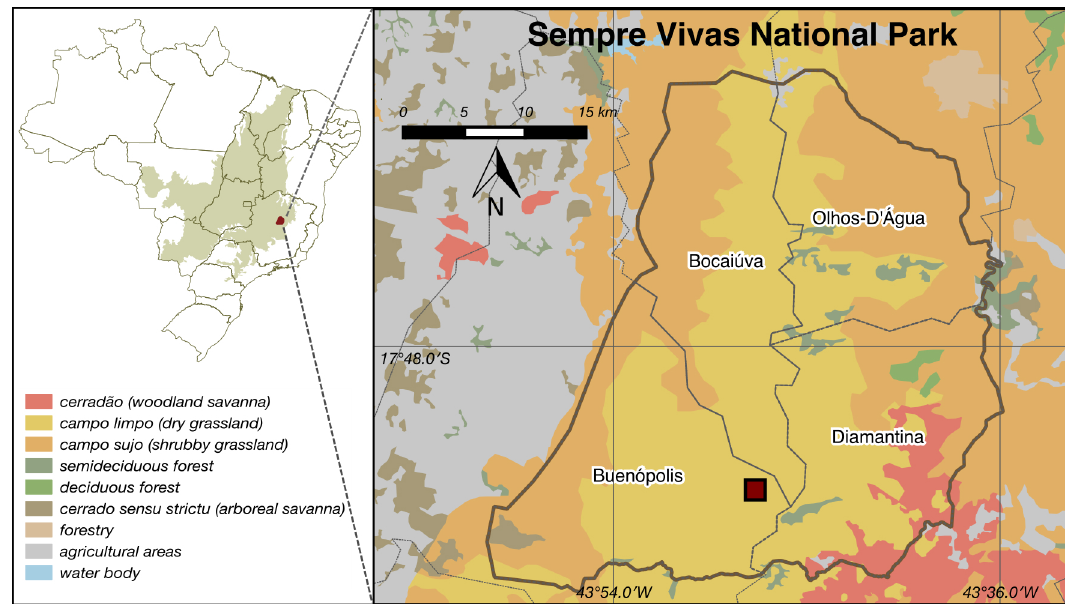
Figure 1. Map showing Sempre Vivas National Park and its vegetation, based on Embrapa Cerrados (2006) and Sano et al. (2007). Red square inside Park area represents collecting locality of the two specimens of Euryzygomatomys spinosus . Names are from municipalities and shaded area in the Brazil inset map corresponds to the Cerrado range.